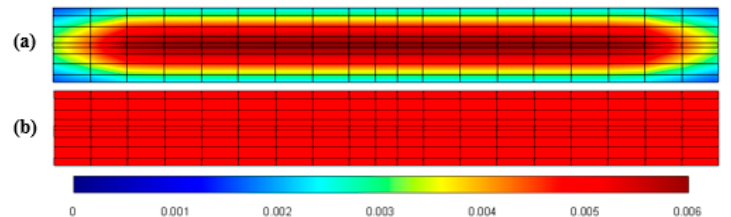
Figure 13. Comparison of the aperture distribution: ( a ) Case 1, ( b ) Case 2.